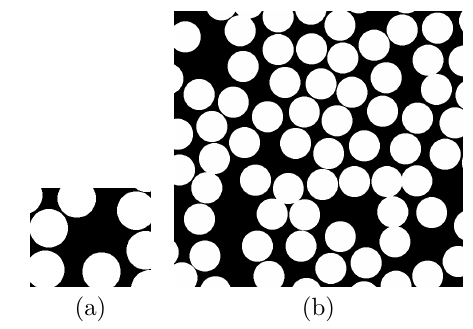
Figure 3. a) Basalt cell with the lowest volume, b) Basalt cell with the highest volume.